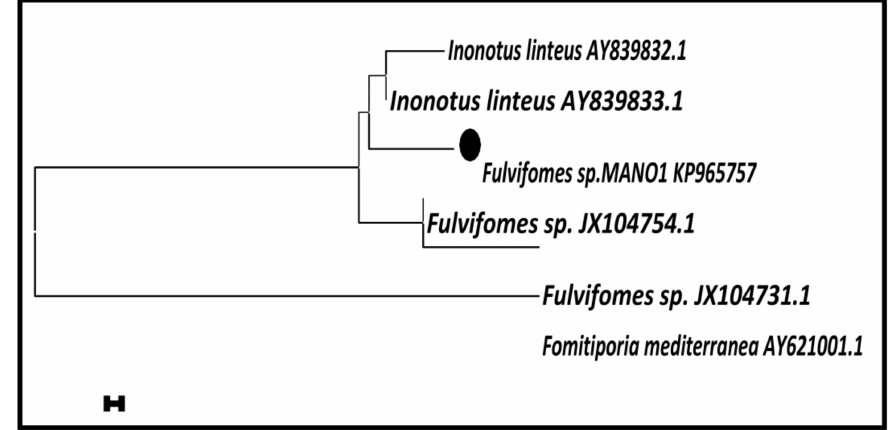
Figure 2. Evolutionary relationships of Fulvifomes sp. (MANO1 KP965757) using neighbor-joining method.